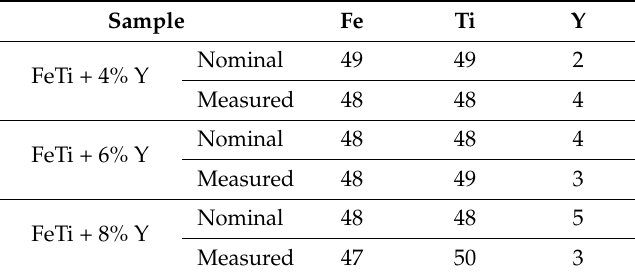
Figure 1. Backscattered micrographs of the as synthesized alloy of Ti-Fe + x wt.% Y (x = 4, 6, and 8).